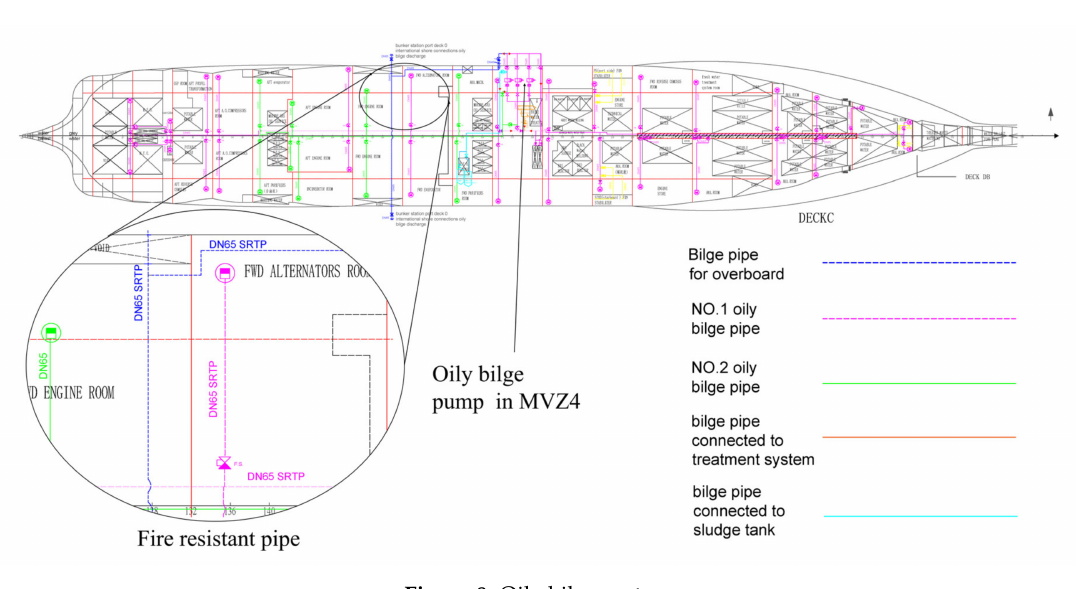
Figure 8. Oily bilge system.